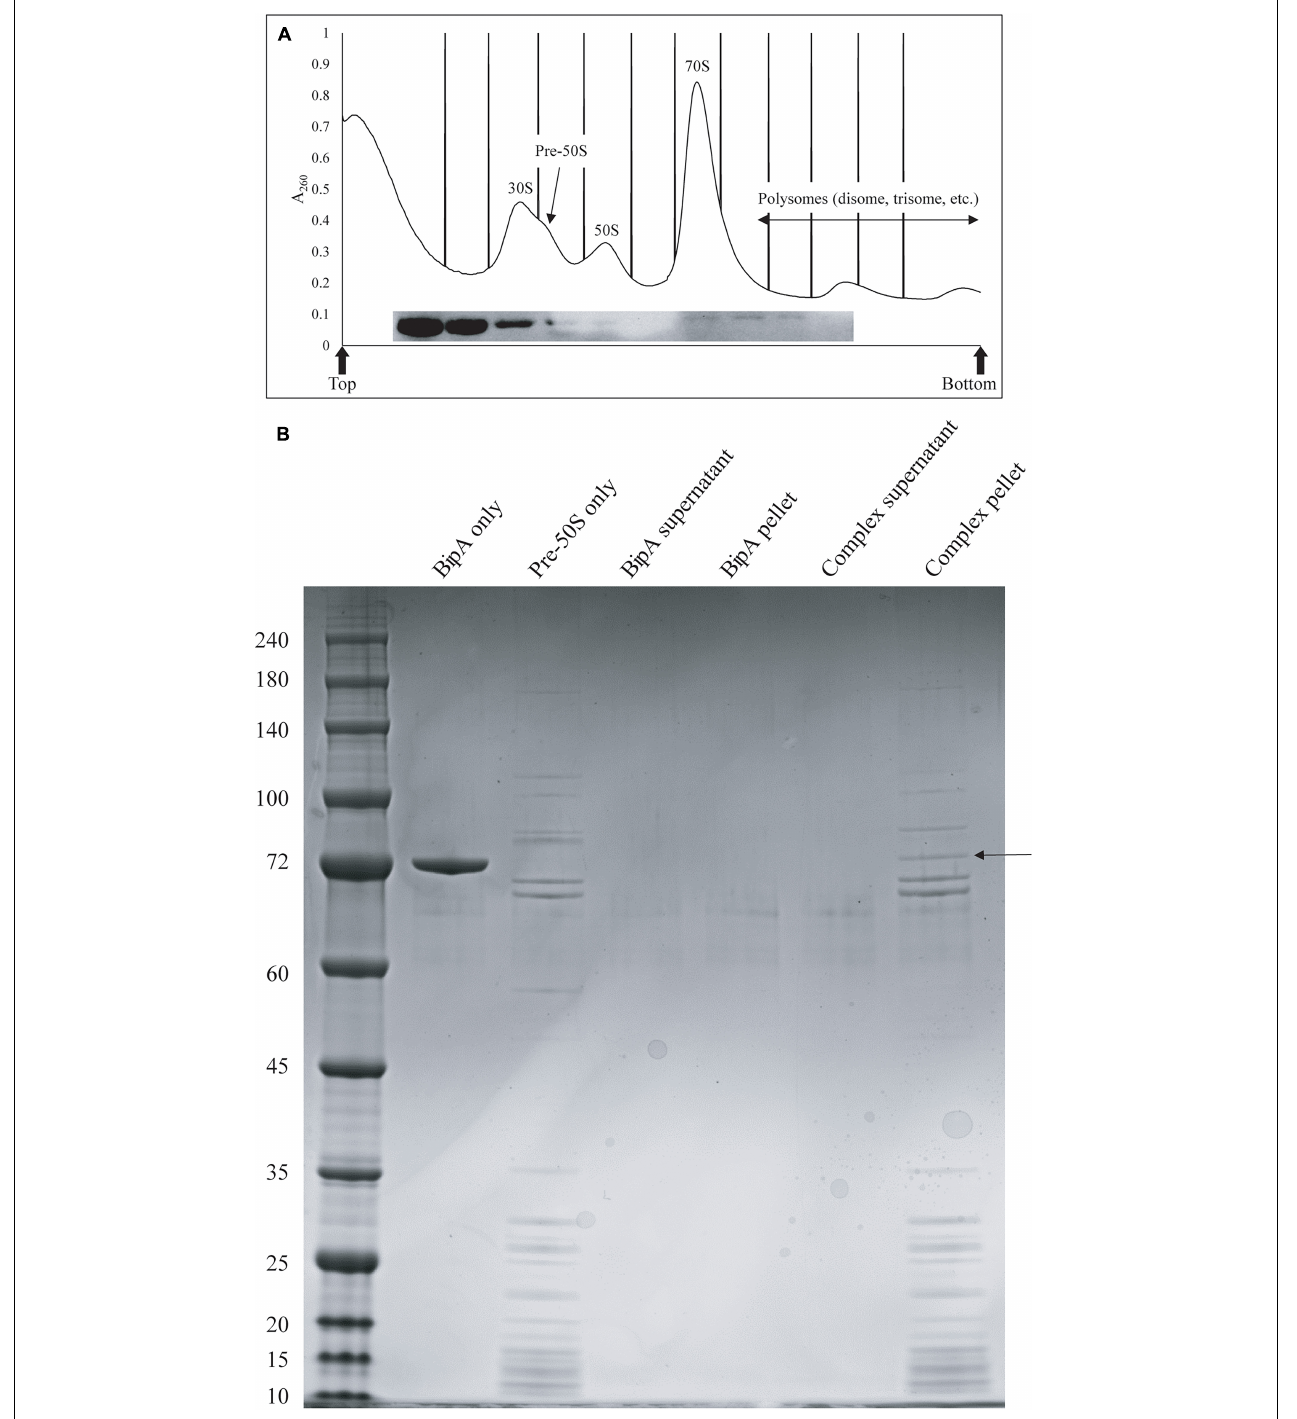
FIGURE 6 | In vitro binding assays showed that BipA pre-incubated with 5X excess GDPCP bound to various ribosomal particles including pre-50S particles. (A) Ribosomal particle distribution of in vitro reconstitution of BipA-GDPCP with ribosomal particles. By analyzing the fractions from ribosomal particle distribution using western blot, most of the BipA pre-incubated with GDPCP were detected in the junk fractions before 30S peak, and the band intensity decreased from 30S toward polysomes. Peaks corresponding to subunits (30S, pre-50S, and 50S), monosomes (70S), and polysomes are indicated. Top and bottom of each gradient are marked with arrows. (B) SDS-PAGE check of ribosome fractions from (A) . BipA interaction with pre-50S was observed based on the presence of co-pelleting through sucrose cushion using ultracentrifugation. The band representing co-pelleted BipA is indicated by the black arrow in the “Complex pellet” lane, which consists of pelleted BipA pre-incubated with GDPCP-bound ribosome complex, suggesting that binding occurs.